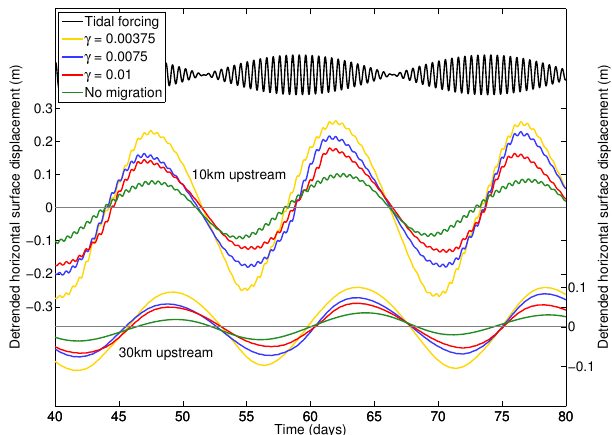
Figure 5. Comparison of detrended in-line displacements for ge- ometries with different slopes. The upper plot shows the tidal forc- ing (scaled down by a factor of 100 and shifted vertically for clar- ity). The middle plot shows in line displacements 10km upstream of the grounding line with and without migration, and the lower plot shows the same 30km upstream.